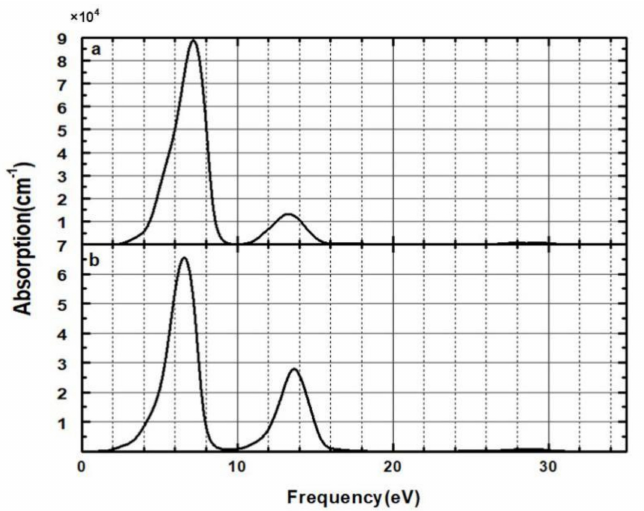
Figure 12. Absorption coefficient of the CsI(Na) (010) surface ( a ) and that of the CsI(Na) (010) surface adsorbing H 2 O molecules ( b ).